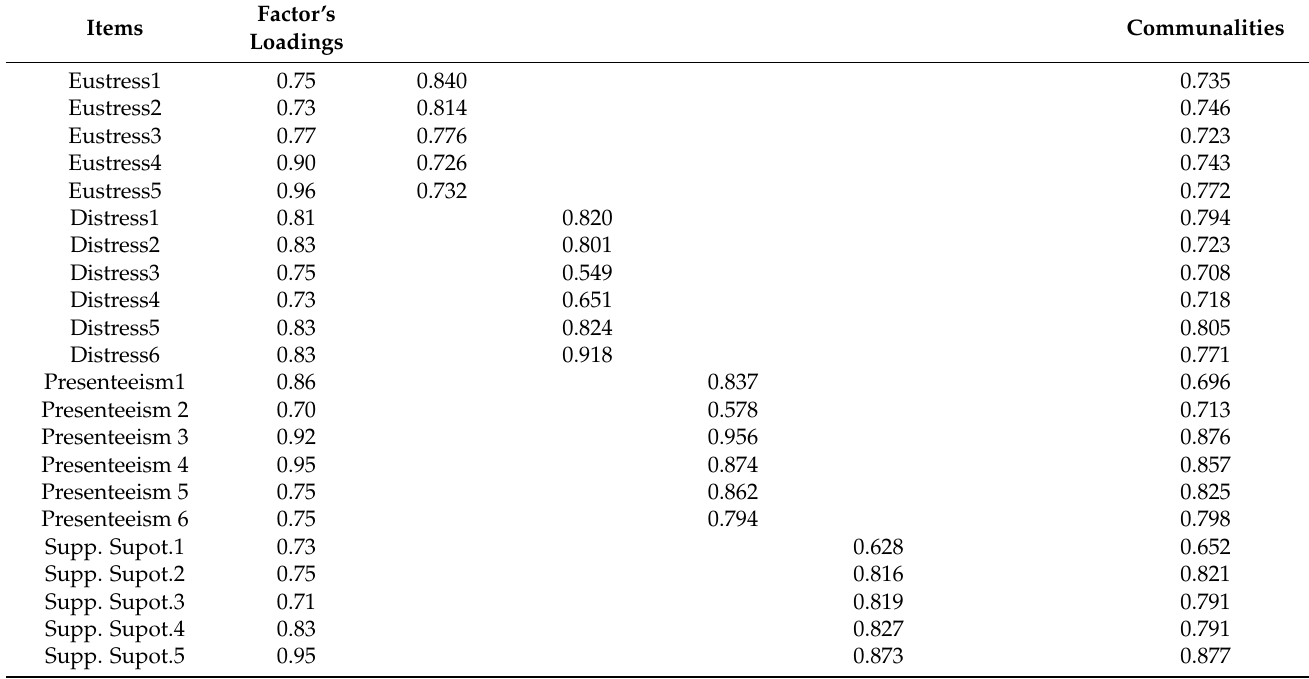
Table 3. Factor loadings, pattern matrix, and